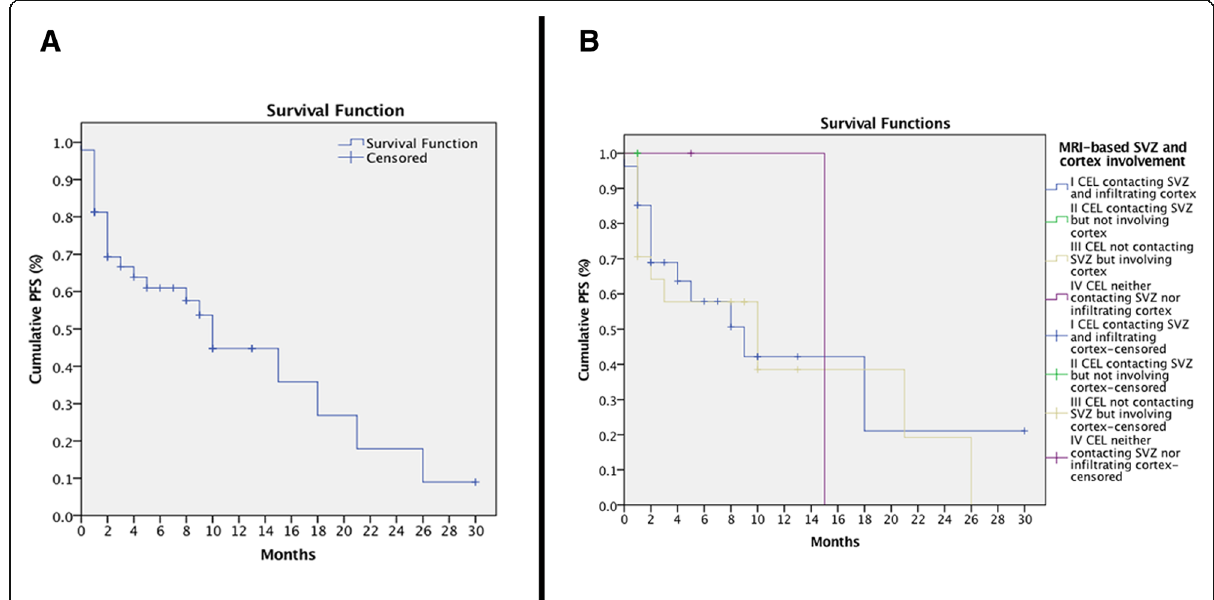
Fig. 4 Curves for progression-free survival. a Progression-free survival curve of the whole sample. b Progression-free survival curves grouped by MRI-based subventricular zone and cortex involvement by